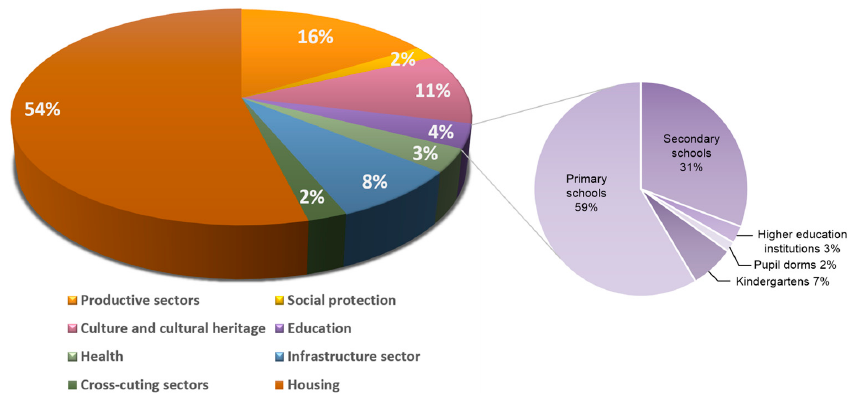
Figure 1. Share of economic estimates of damage and loses after Petrinja earthquake (adopted from [14]). from